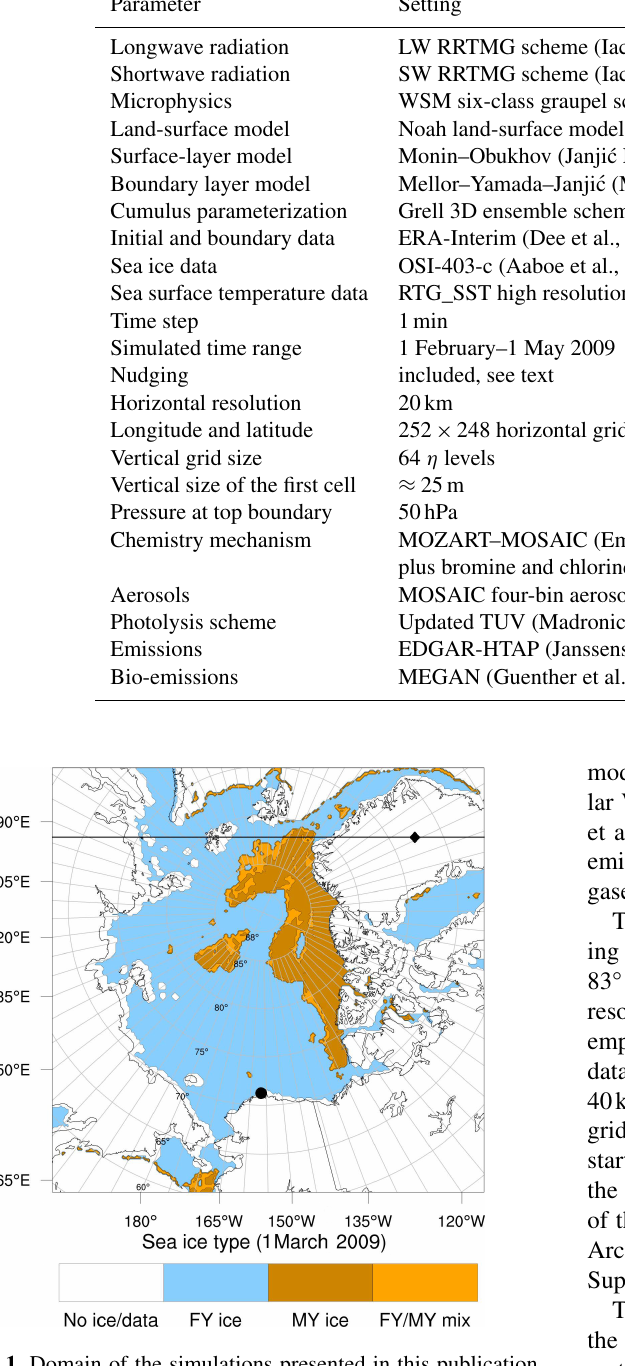
Figure 1. Domain of the simulations presented in this publication and sea ice type (Aaboe et al., 2017) with the locations of ( • ) Utqia˙gvik, Alaska, and ( (cid:7) ) Summit, Greenland, respectively. For latitudes larger than 88 ◦ , missing sea ice type data are filled up with FY ice. The horizontal line refers to the x coordinate in Fig.